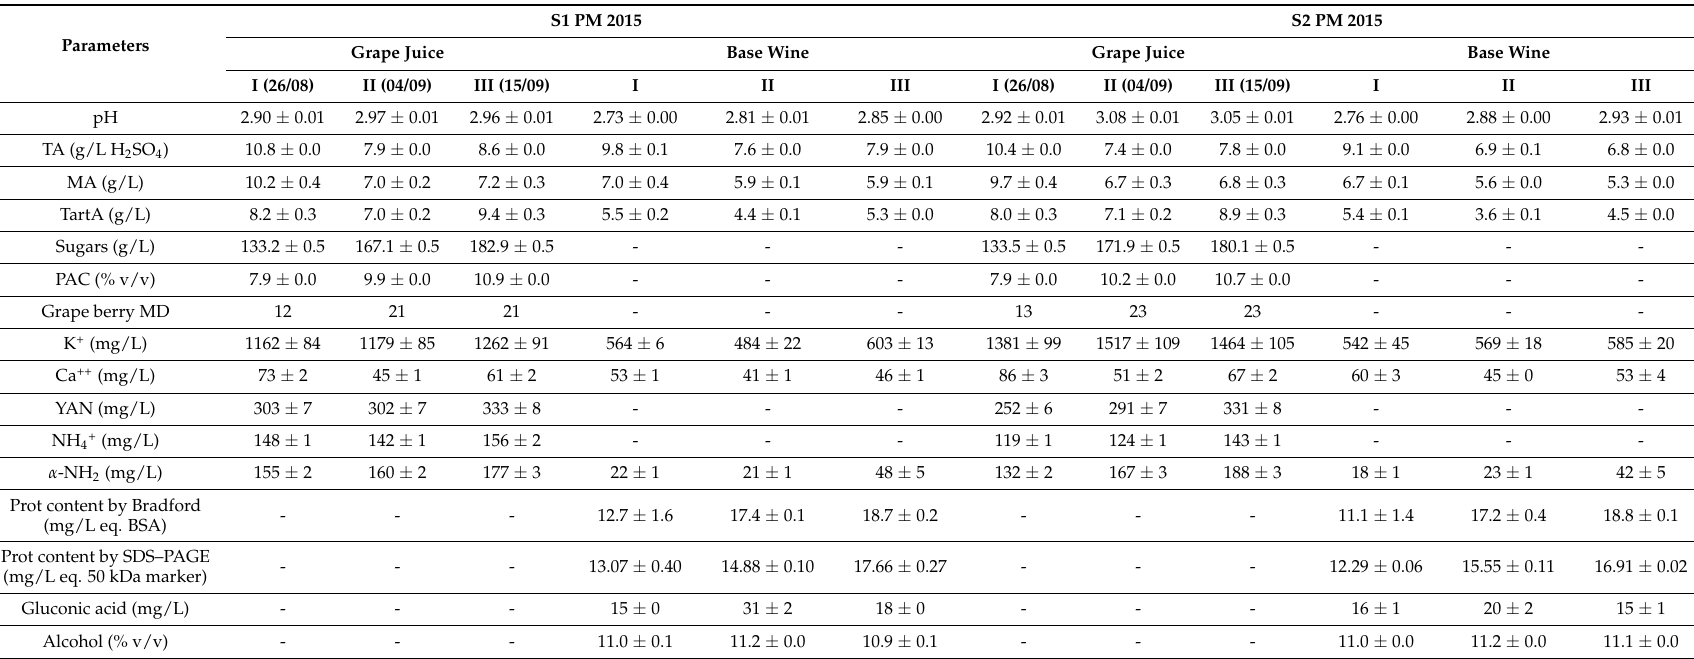
Table 1. Oenological parameters of Pinot meunier grape juices and base wines at different grape berry maturity